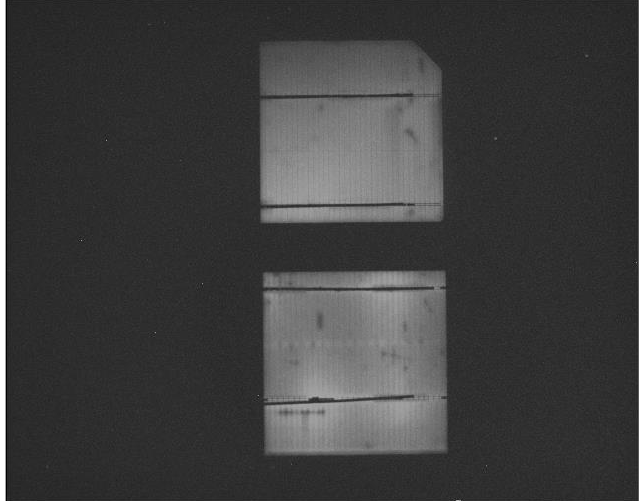
Figure 19. Images I of solar cells (from top to bottom, the monocrystalline and polycrystalline silicon photovoltaic cell).